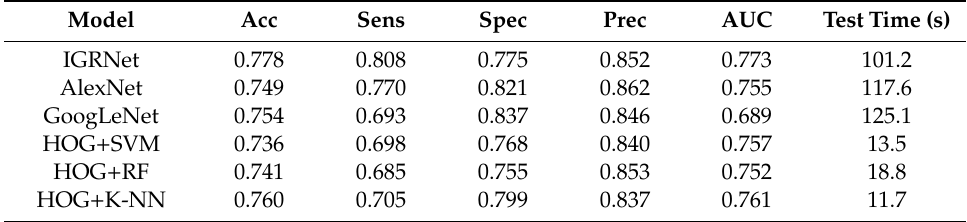
Table 10. Experimental results using di ff erent machine learning models on the total independent test